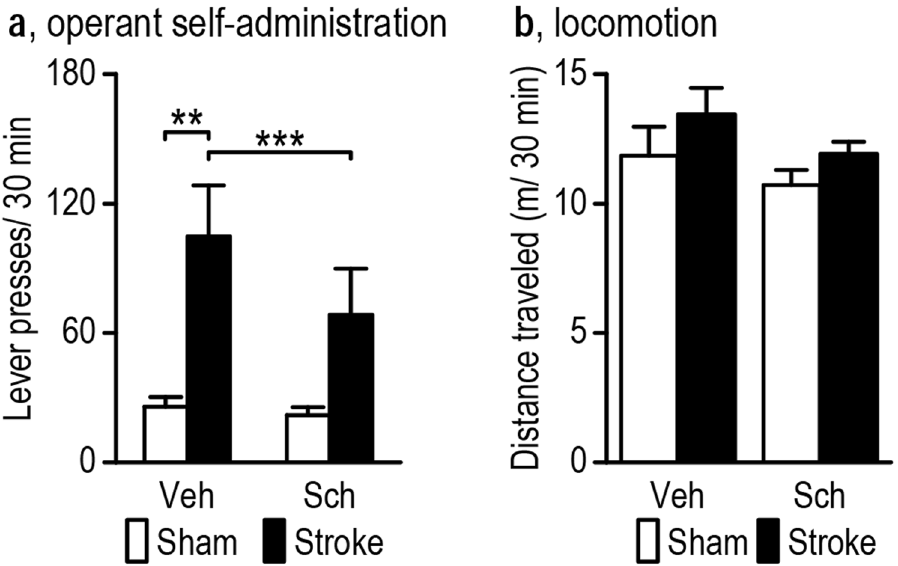
Figure 8. D1 receptor inhibition attenuates the stroke-induced increase in operant alcohol self-administration. Sprague-Dawley rats were administered an intraperitoneal injection of saline (Veh, 1 ml/kg) or SCH 23390 (SCH, 1 µ g/ml/kg) 30 min prior to the operant self-administration session. ( a ) D1 receptor inhibition by SCH did not affect operant lever presses in the sham group and significantly decreased operant lever presses in the stroke group, as compared to vehicle-treated rats. ** p < 0.01 and *** p < 0.001, two-way RM ANOVA followed by the post-hoc SNK test. n = 6 (Sham) and 6 (Stroke) rats. ( b ) D1 receptor inhibition by SCH had no effect